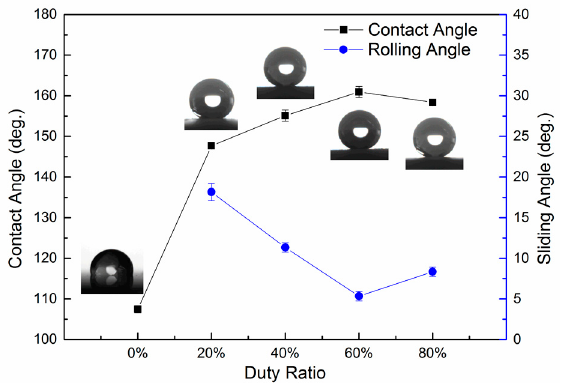
Figure 7. Water contact angle and sliding angle of pulse electrodeposited surfaces as a function of pulse current duty ratio.